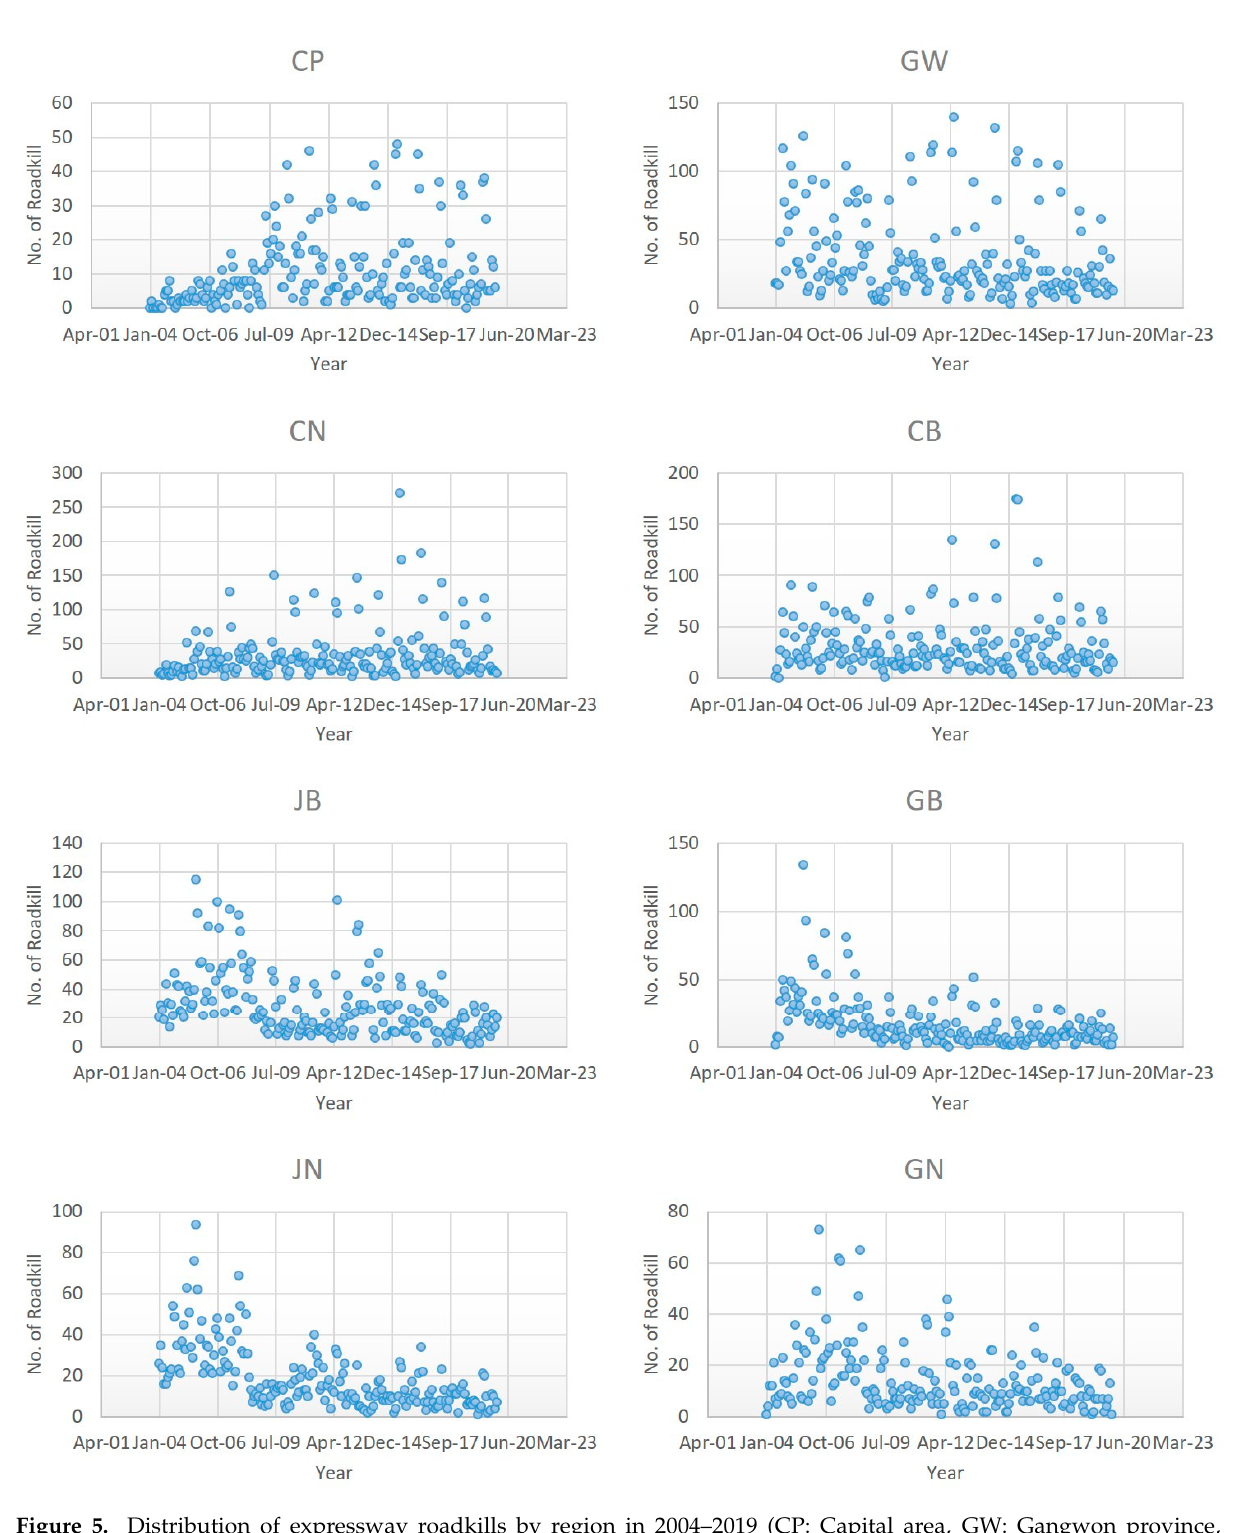
Figure 5. Distribution of expressway roadkills by region in 2004–2019 (CP: Capital area, GW: Gangwon province, CN: Chungnam province, CB: Chungbuk province, JB: Jeonbuk province, GB: Gyeongbuk province, JN: Jeonnam province, GN: Gyeongnam province).